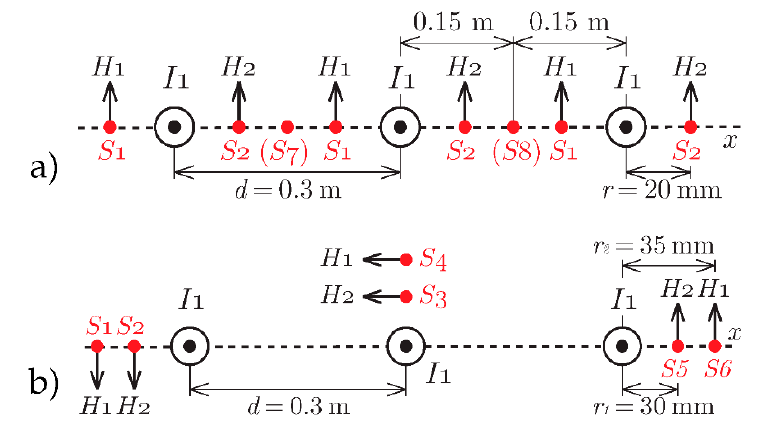
Figure 1. In-line placement of 6 or 8 sensors as described in Sections 2.1 and 2.3 ( a ) compared to [1] ( b